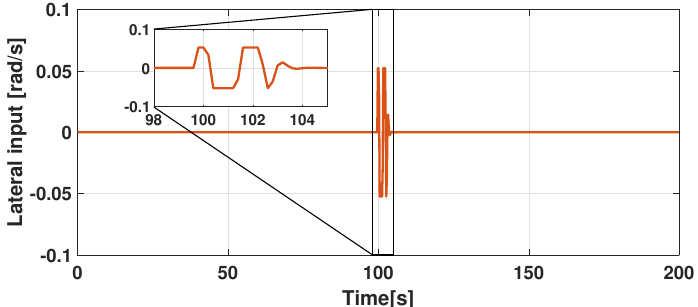
Figure 9. Single lane changing scenario . Performance of the proposed solution and comparison analysis w.r.t. IDM solution. Time-history of the ego vehicle lateral input u 1 ( t ) .